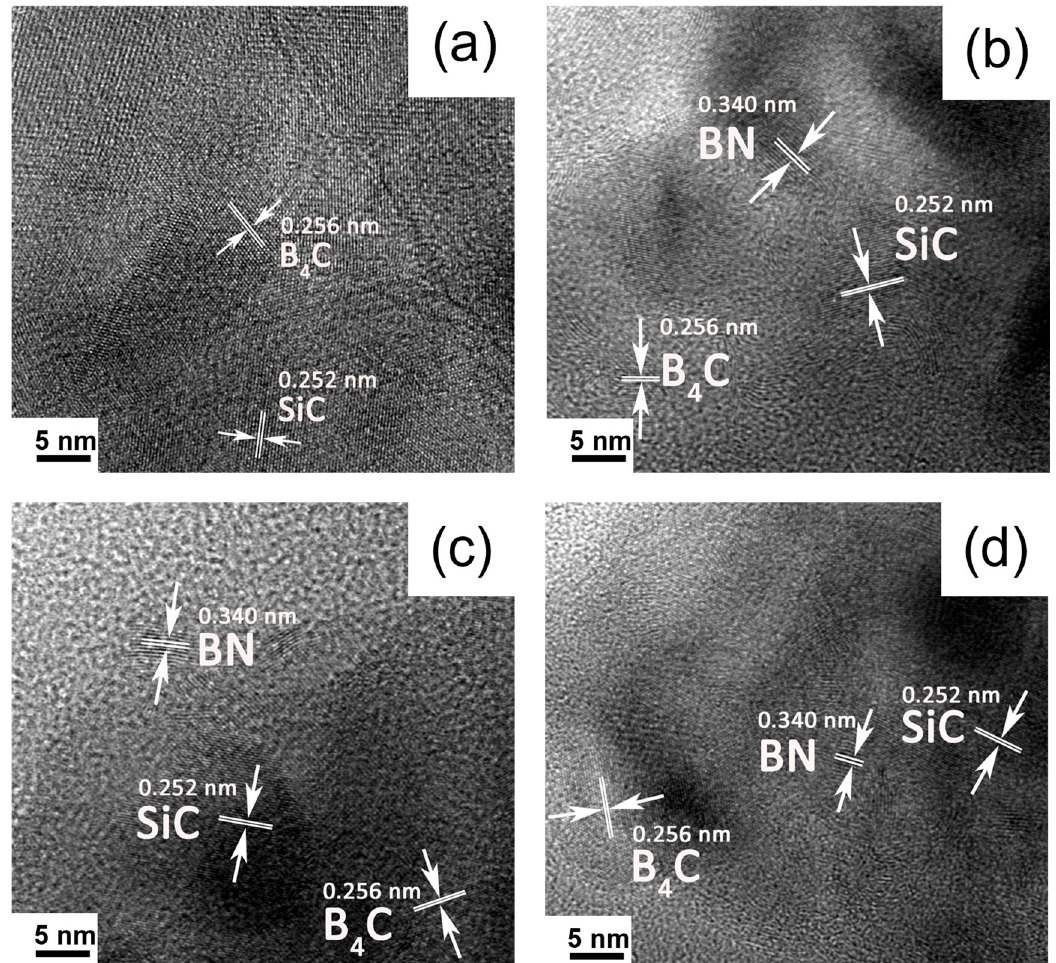
Figure 5. TEM images of SiBCN0:1 ( a ), SiBCN3:1 ( b ), SiBCN6:1 ( c ), and SiBCN8:1 ( d ) treated at 1600 °C.